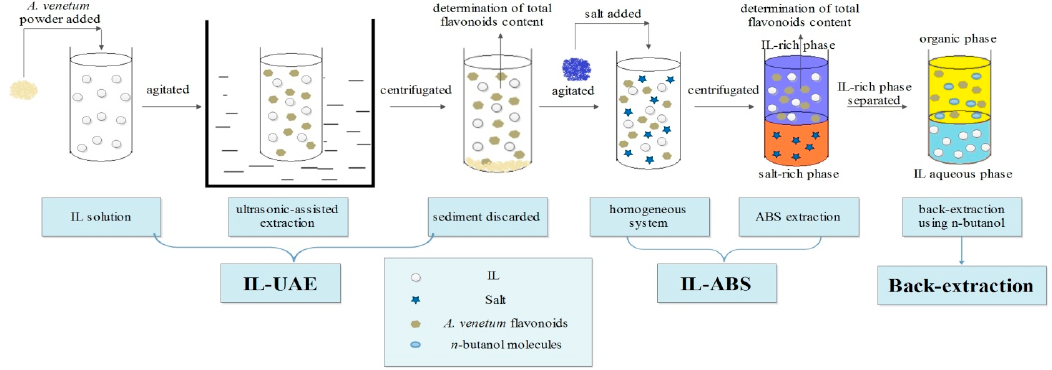
Figure 1. Process flowchart for the extraction and purification of flavonoids from Apocynum venetum L. using IL-UAE coupled with IL-ABS and back-extraction.